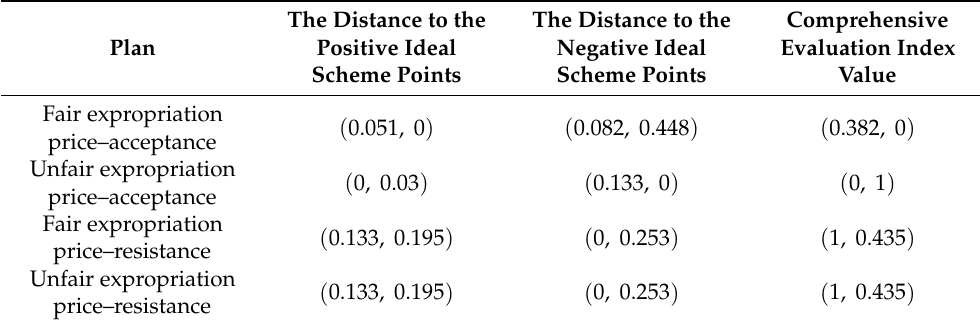
Table 6. Distance from each scheme to positive and negative ideal scheme points and the comprehen- sive evaluation index